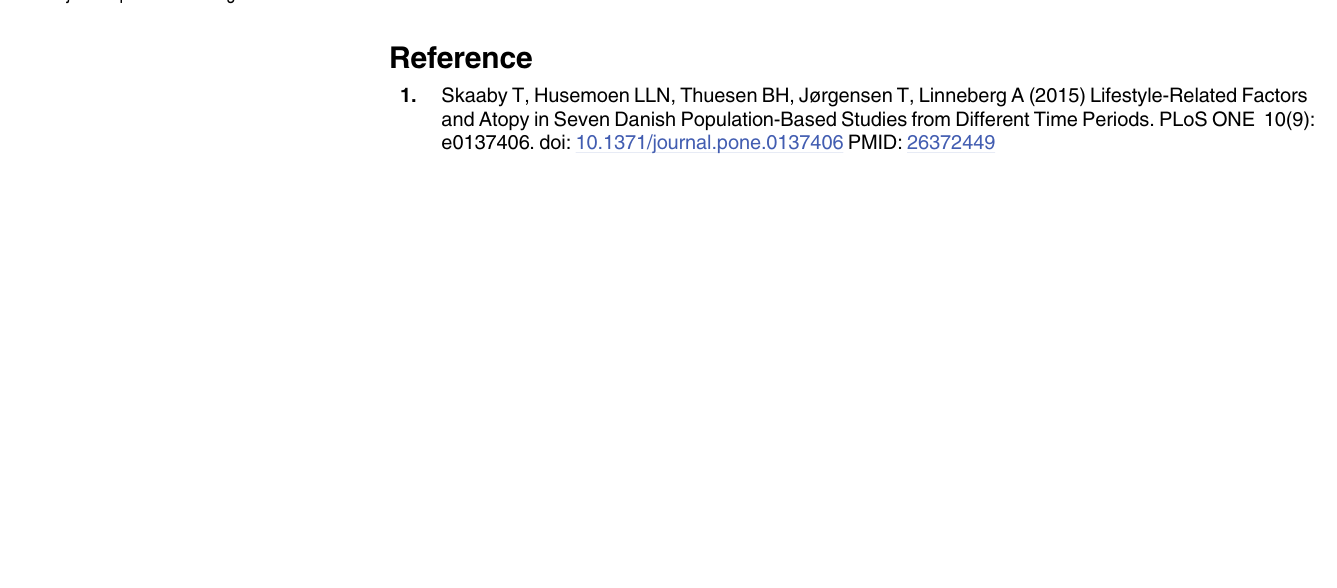
Fig 1. Overview of the results of meta-analyses of the study-specific estimates of the associations of atopy with possible lifestyle-related factors. Abbreviations: OR, odds ratio; CI, confidence interval; vs., versus.